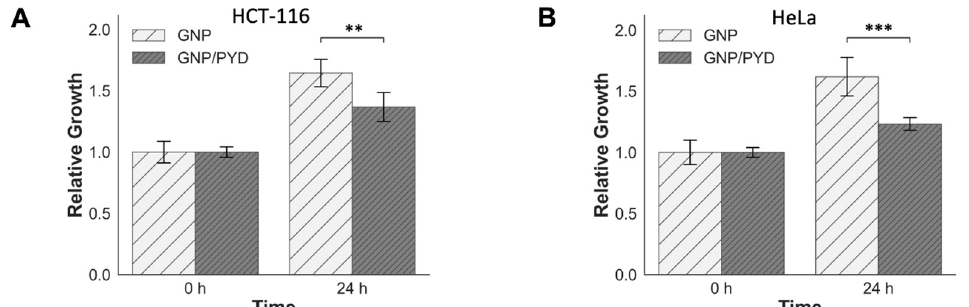
Figure 8. Relative growth of cells after a 2 Gy radiation dose at 6 MV delivered by a clinical linear